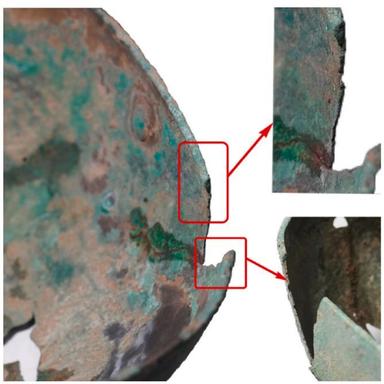
Cross-section of XJN22, showing that the rim is thicker than other areas.